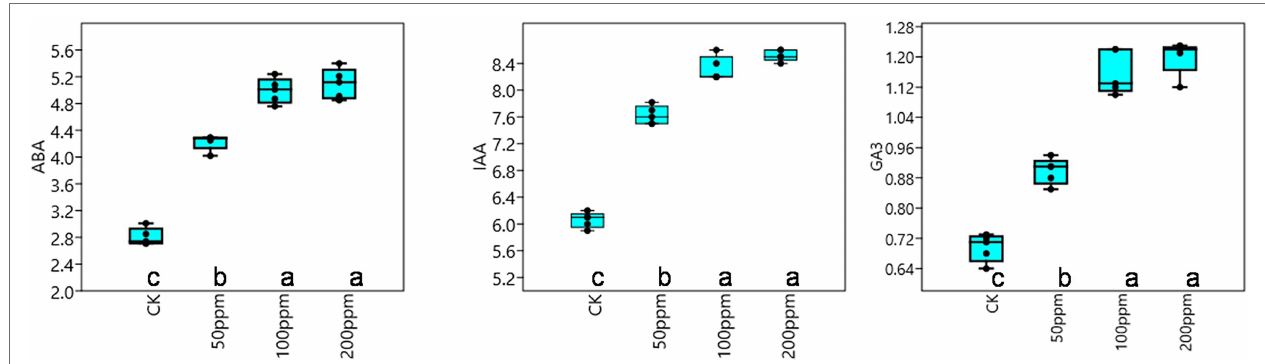
FIGURE 4 | Response of IBA on different endogenous hormones, ABA ( μ g g − 1 FW), IAA (nMol g − 1 FW), and GA 3 (nMol g − 1 FW). Bars with different letters indicate significant differences at the p < 0.05 according to